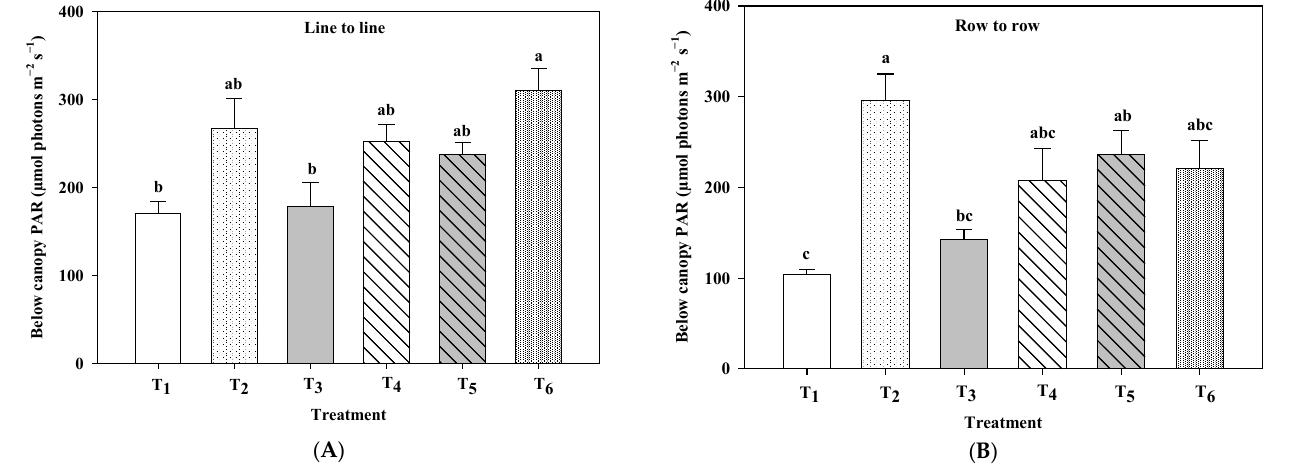
Figure 4. Photosynthetically active radiation (PAR) under the canopy of different sole and intercrop- ping treatments. For treatment abbreviations, see Figure 1. PAR was measured between lines (panel ( A )) and between rows (panel ( B )) since canopy coverage was different due to spacing (e.g., the line to line = 60 cm and plant to plant = 20 cm for maize) of the crops. Different letters above the bars indicate statistically significant differences at Tukey’s HSD (a = 5%). The error bars represent the standard error of means, N =